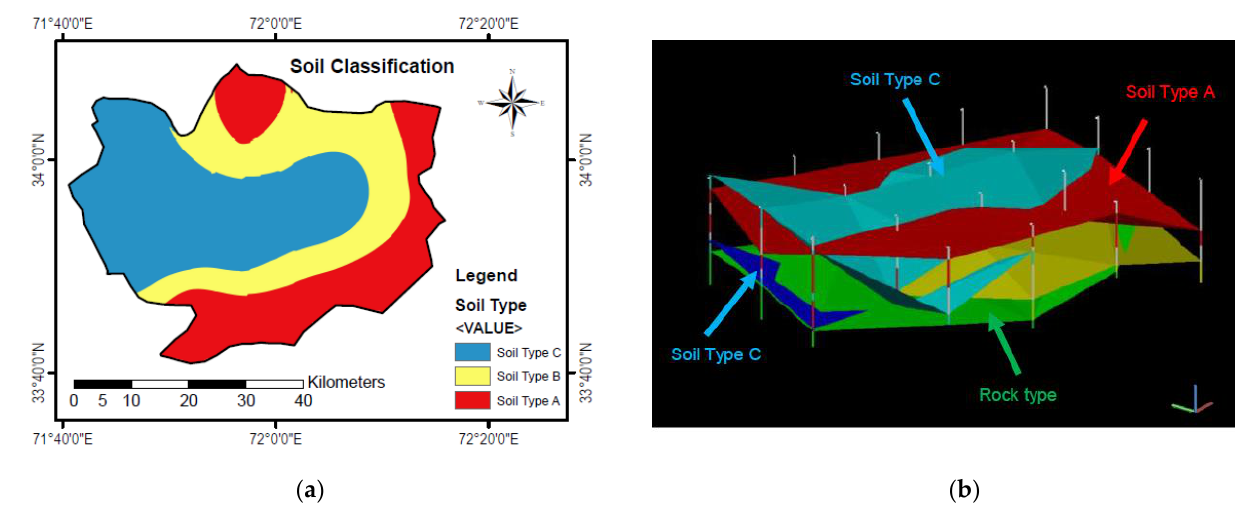
Figure 10 Figure 10. ( a ) Soil classification map representing soil type in different regions according to OSHA defined soil classification; ( b ) Three-dimensional visualization of soil type according to OSHA (some of the layers were kept hidden for